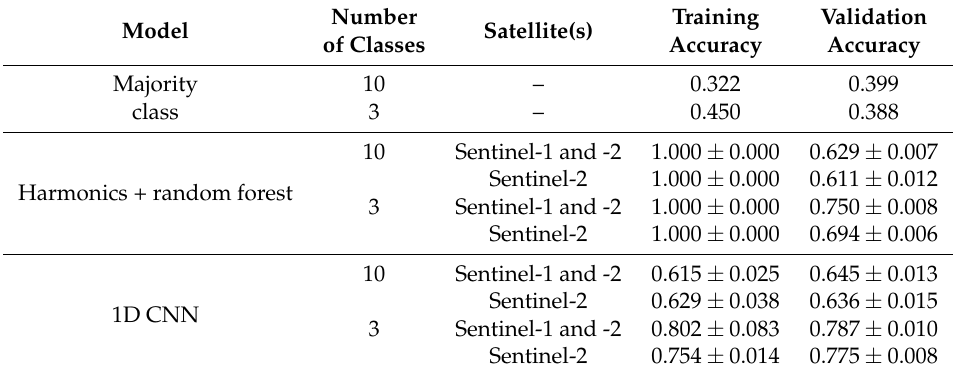
Table A7. The additional value of Sentinel-1. Training and validation accuracies for the 10-crop classification problem and 3-class problem are compared between models using both SAR and optical (Sentinel-1 and -2) satellite imagery and only optical satellite imagery